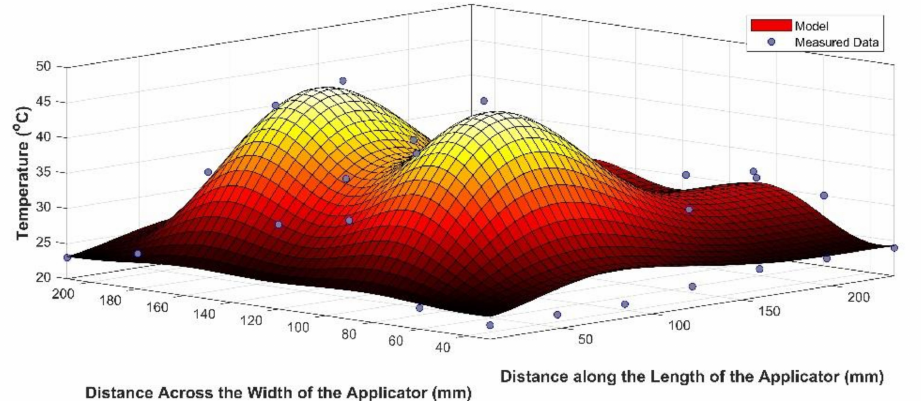
Figure 7. Temperature distribution in the soil on the depth 10 mm by ceramic applicator after MW heating at F = 2.45 GHz, p = 3.5 kW, time of MW heating 15 s, T o = 23 ◦ C, applied energy 53 kJ. Soil moisture content 89%, density 710 kg m − 3